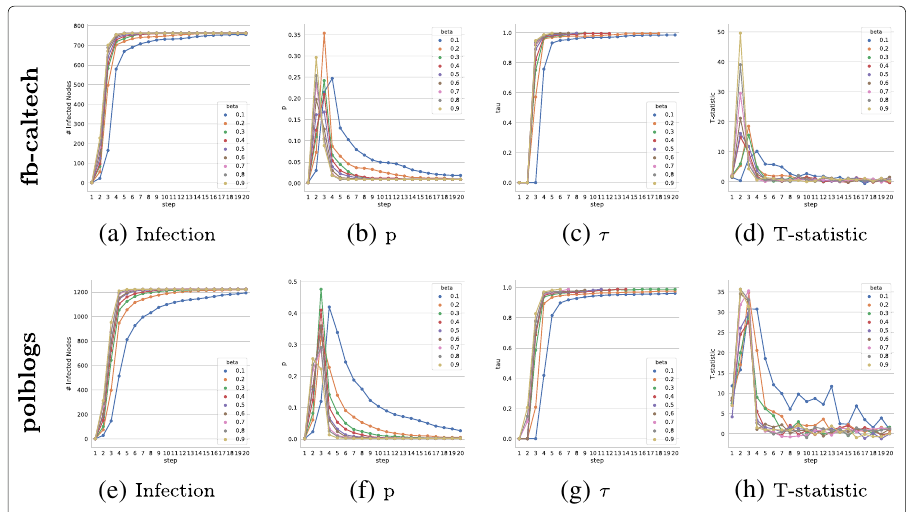
Fig. 7 Graph vulnerability over the series of epidemic graphs under SI model. During each infection step, a susceptible node becomes infected with probability β if in contact with an infected node. a , e the rate of infection; b , f p – diversity ratio which measures the proportion of nodes with one binary attribute value; c , g τ – estimated value of homophily observed in the network; and d , h the T-statistic value between prediction scores of GS(LBL) and GS. T-statistic values show how the extra vulnerability due to binary attributes changes over iterations of the epidemic